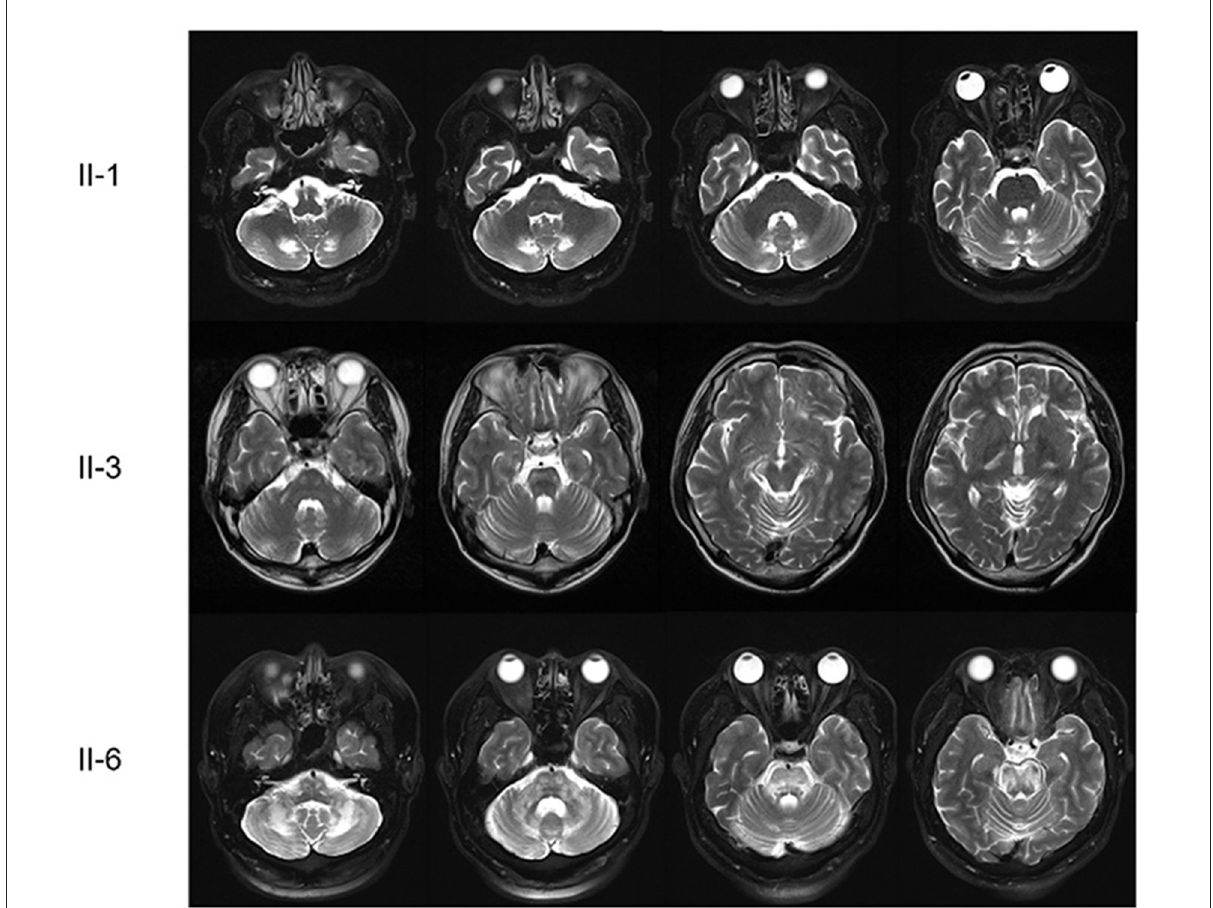
FIGURE2 Brain MRI scans of the patients. The proband (II-1) had symmetric T2-weighted hyperintensities in the dentate nuclei and the surrounding cerebellar white matter. The first younger brother (II-3) presented brainstem and cerebellar atrophy with asymmetric T2-weighted hyperintensities in the middle cerebellar peduncles, cerebral peduncles, posterior limbs of the internal capsules, and periventricular white matter of the frontal lobe. The third younger brother (II-6) had diffuse T2-weighted hyperintensities in the midbrain, pons, middle cerebellar peduncle and